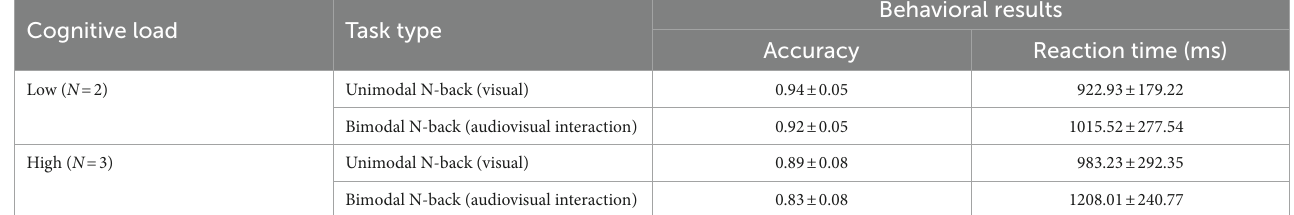
TABLE 1 Behavioral performance on the unimodal N-back task (visual) and bimodal N-back task (audiovisual interaction; mean ± standard deviation).